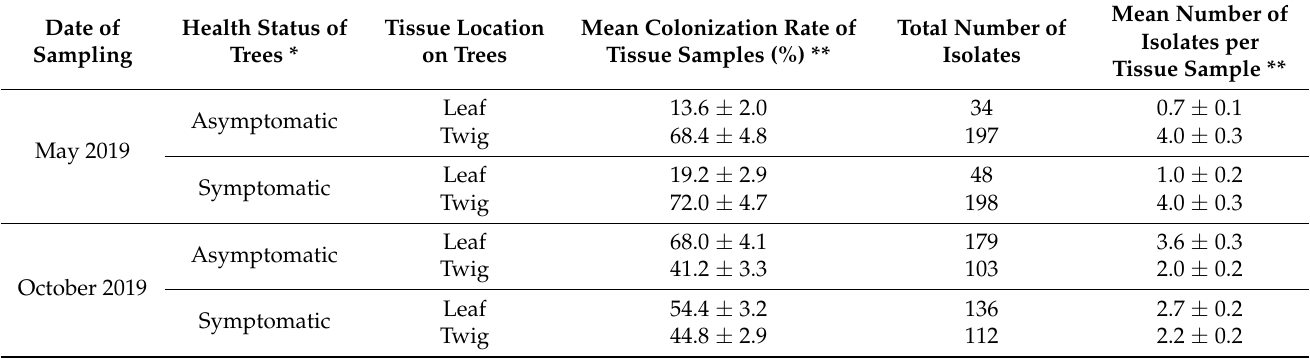
Table 1. Isolation of endophytic fungi on malt extract agar plates from different types of tissue samples collected from Fraxinus excelsior in Slovakia in